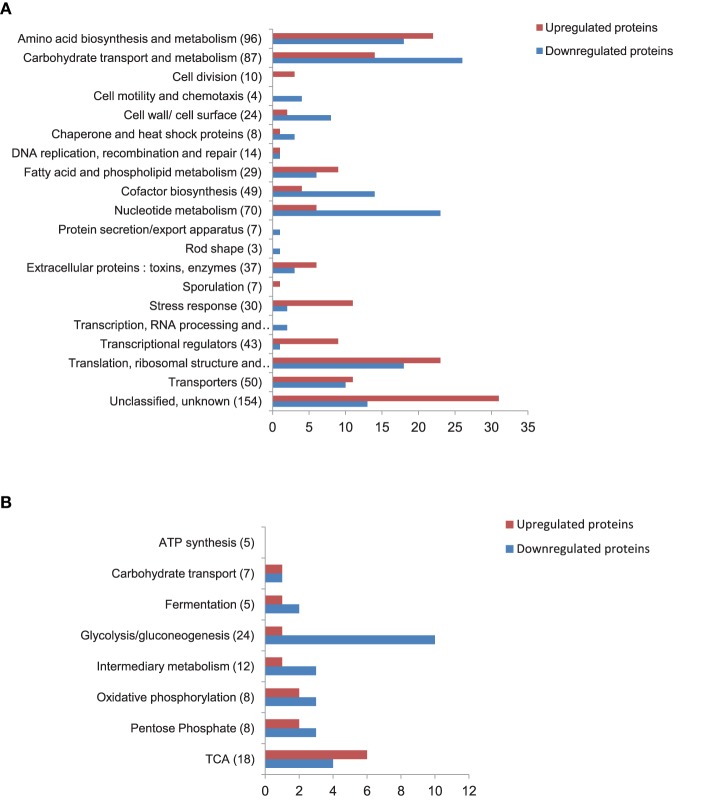
Distribution of cellular proteins identified by shotgun proteomics showing significant abundance level changes (p < 0.05) between wild-type and ΔentD mutant strains. (A) Distribution of downregulated (blue) and upregulated (red) proteins into 20 groups according to their functions. The number of total proteins identified in each functional group is given in brackets. (B) Sub distribution of downregulated (blue) and upregulated (red) proteins classified into the carbohydrate transport and central metabolism functional group. The number of total proteins identified in each of the 8 subgroups is given in brackets.